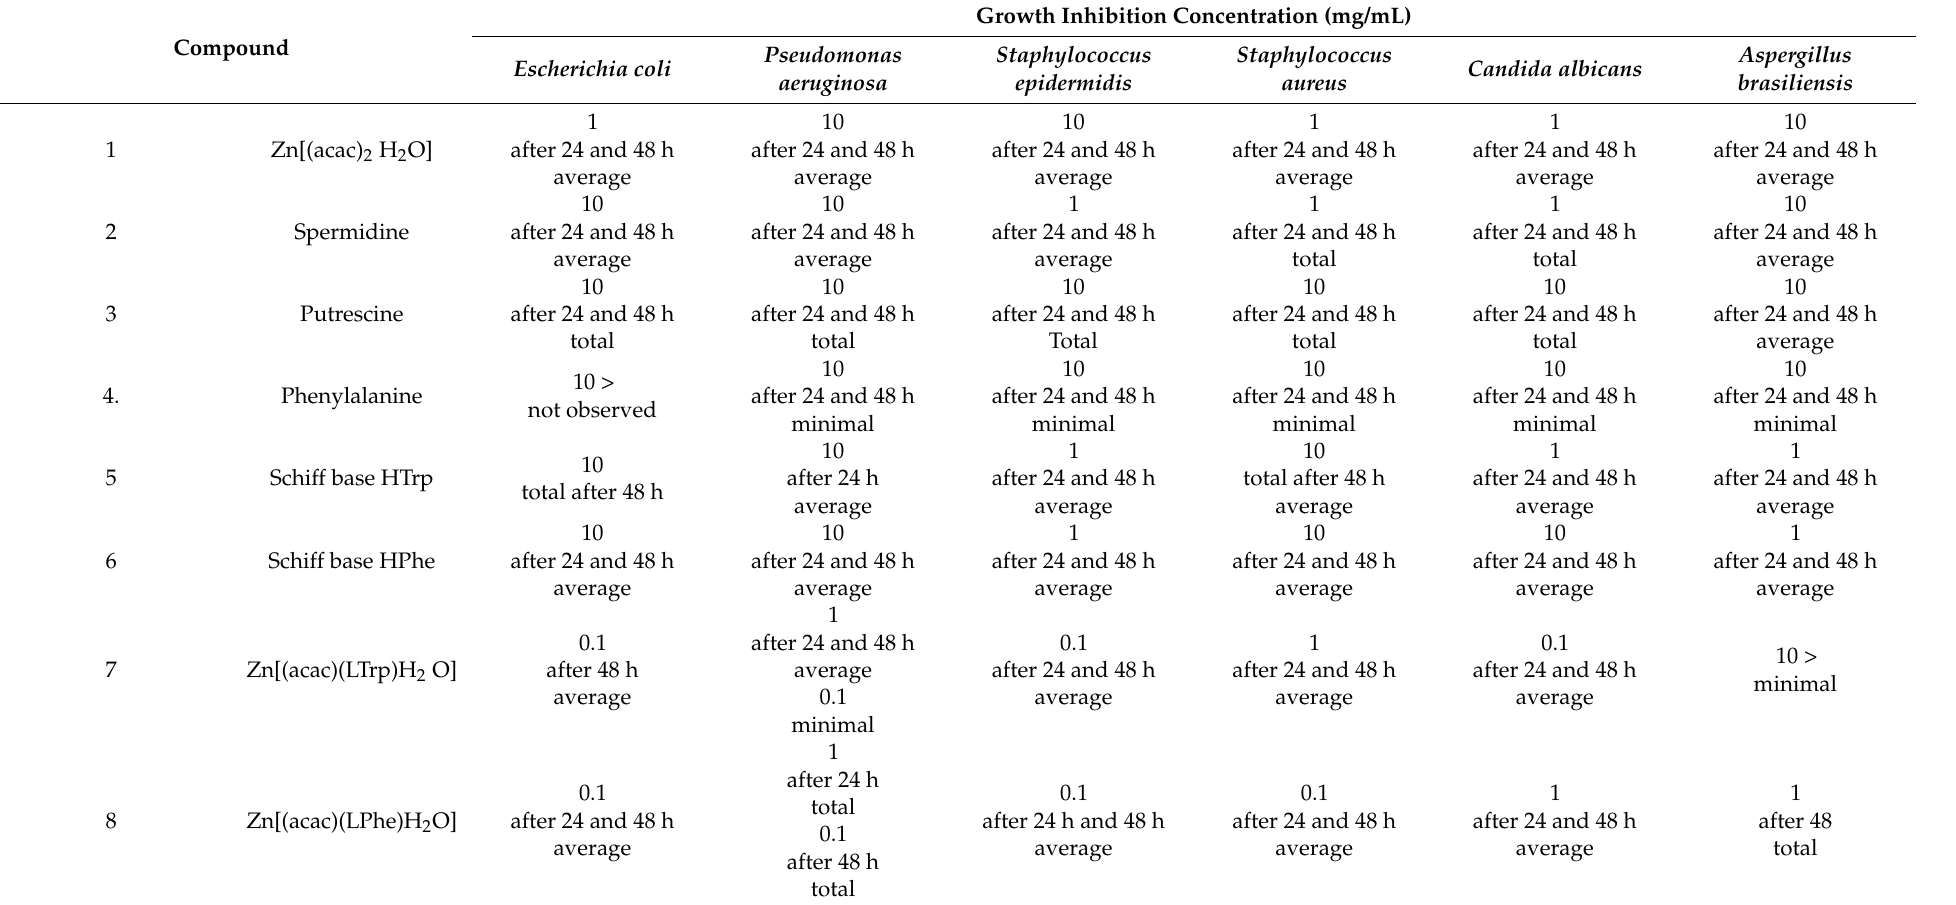
Table 1. Screening of the effect of the present selected compounds on the inhibition of the growth of bacterial and fungal strains (own research results). Approximate values of the minimum inhibitory concentration